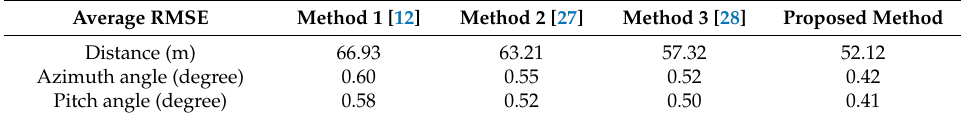
Table 11. The average root-mean square error (RMSE) of key parameters among four methods.